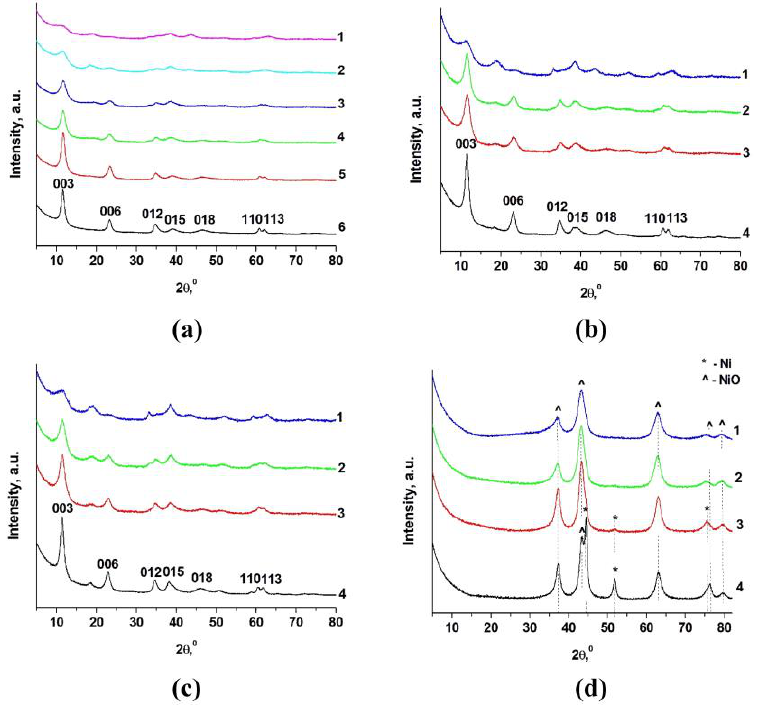
Figure 1. XRD patterns of the samples: ( a ) (Ni + Mg)/Al = 2, 1-NiAl-2, 2-0.7NiMgAl-2, 3-0.5NiMgAl- 2, 4-0.3NiMgAl-2, 5-0.1NiMgAl-2, 6-MgAl-2; ( b ) (Ni + Mg)/Al = 3, 1-NiAl-3, 2-0.5NiMgAl-3, 3- 0.3NiMgAl-3, 4-MgAl-3; ( c ) (Ni + Mg)/Al = 4, 1-NiAl-4, 2-0.5NiMgAl-4, 3-0.3NiMgAl-4, 4-MgAl-4; ( d ) samples after calcination and reduction pretreatments: 1-0.5NiMgAl-2-R, 2-0.5NiMgAl-4-R, 3- NiAl-3-R, 4-NiAl-4-R